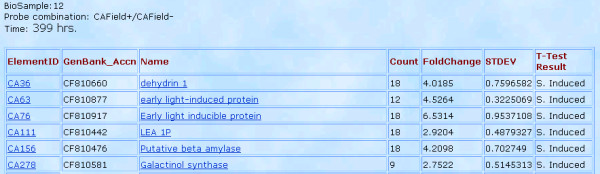
A snap shot showing the results obtained when querying BBGD for genes that had an expression ratio of >= 2 fold. Among the fields that are returned are results from standard deviation calculations (STDEV) and T-test calculations summary (significantly induced/suppressed or no change). Users can get the sequence by clicking on the clone ID and/or can query PubMed for relevant articles by clicking on the gene name.